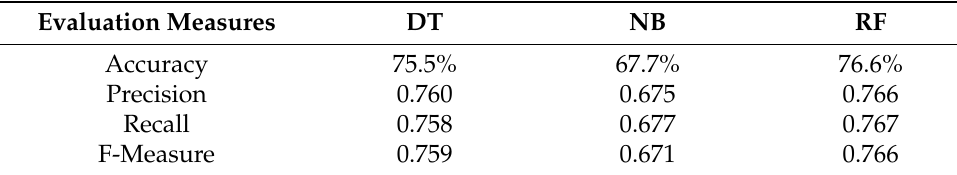
Table 2. Classification results with traditional